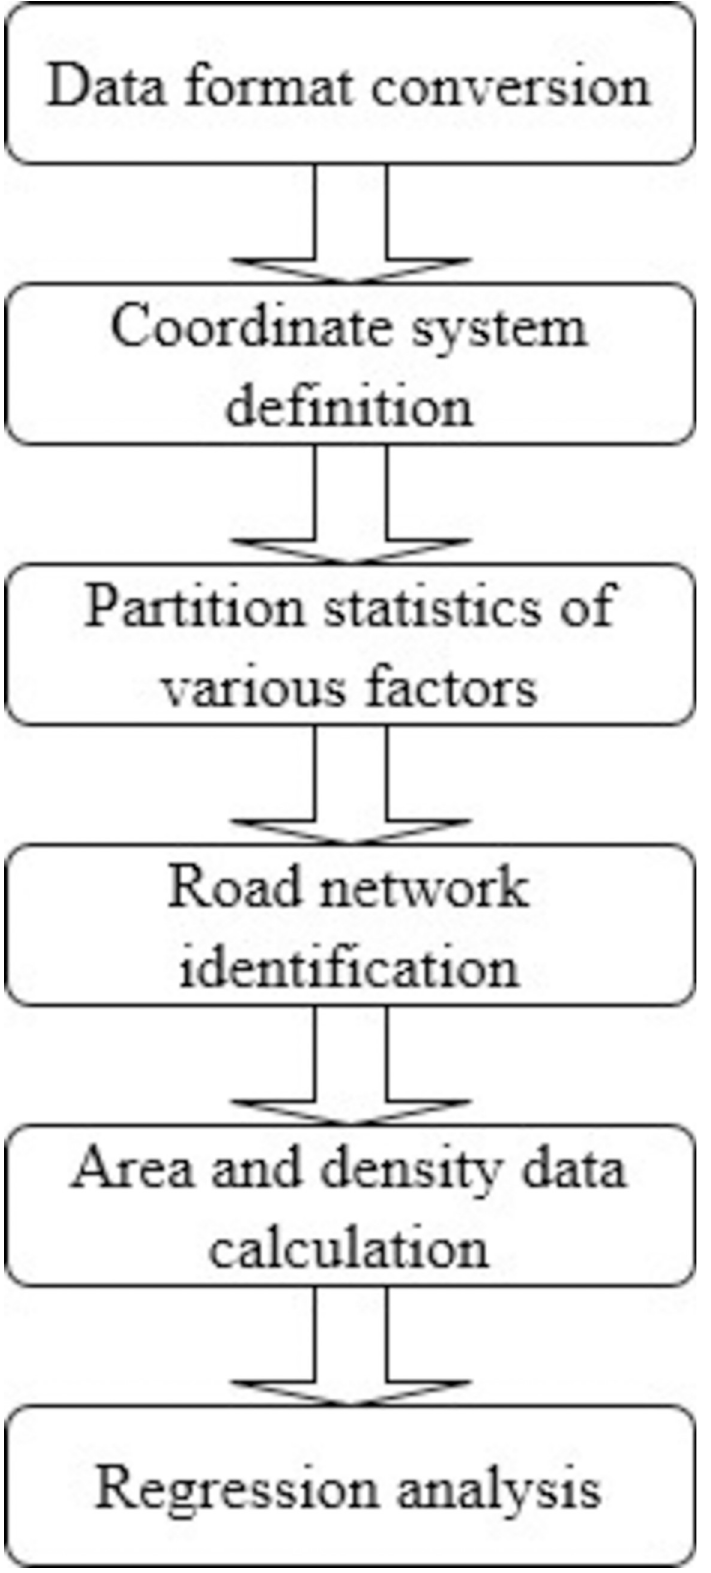
Fig 2. Flow chart of experimental